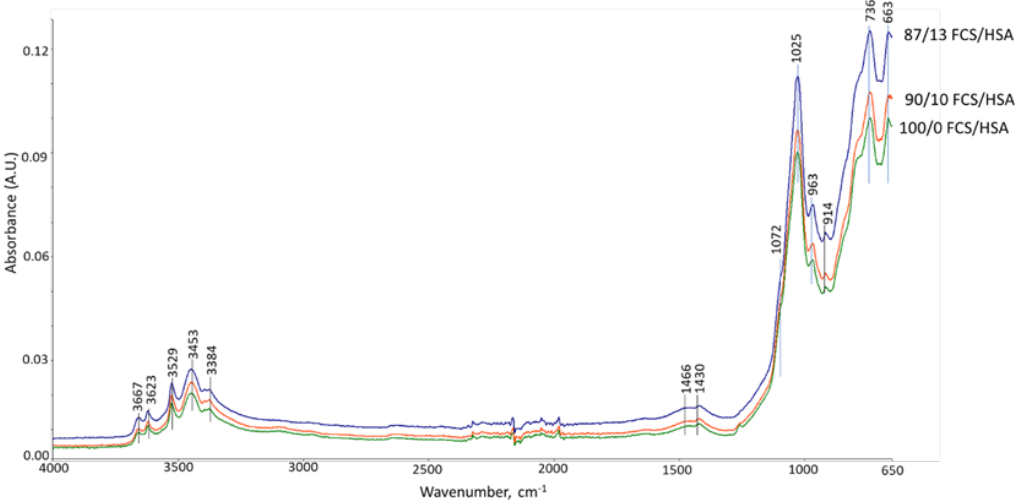
Figure 35. ATR-FTIR spectra of 100 ◦ C-autoclaved 100/0, 90/10, and 87/13 ratio composites.